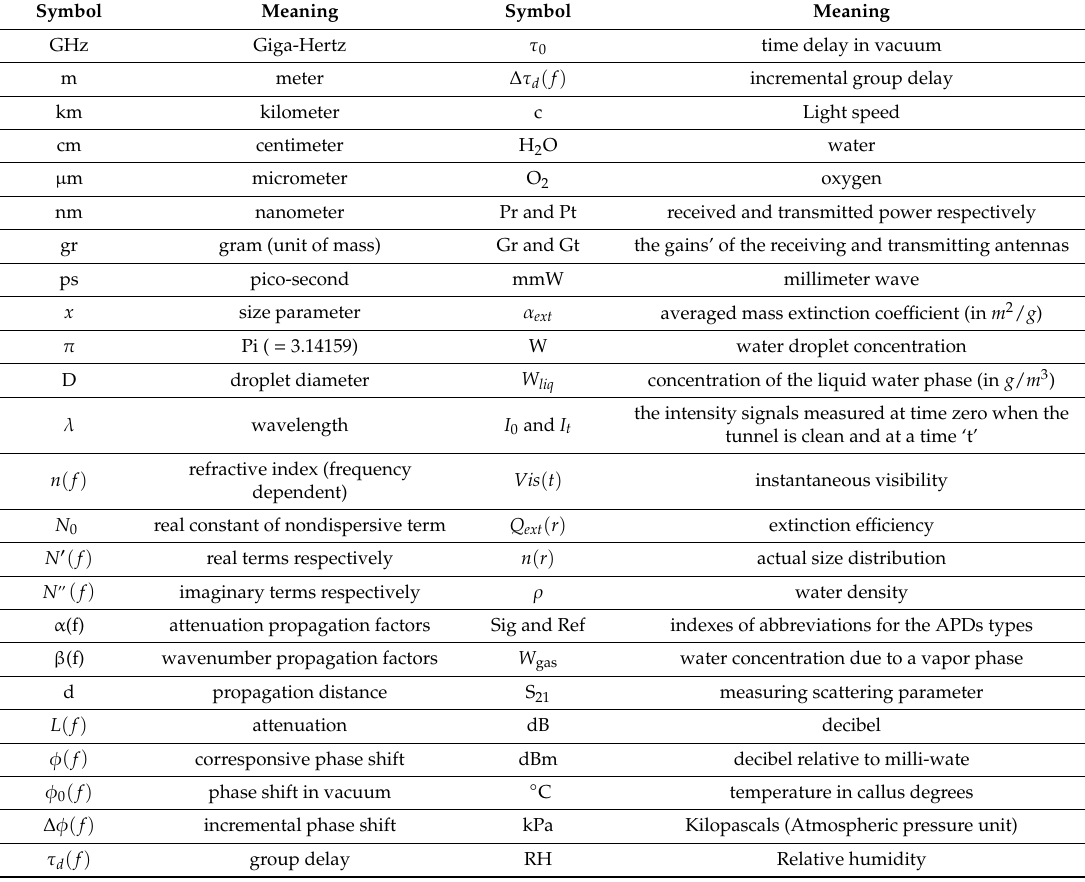
Table A1. Mathematical Nomenclature and